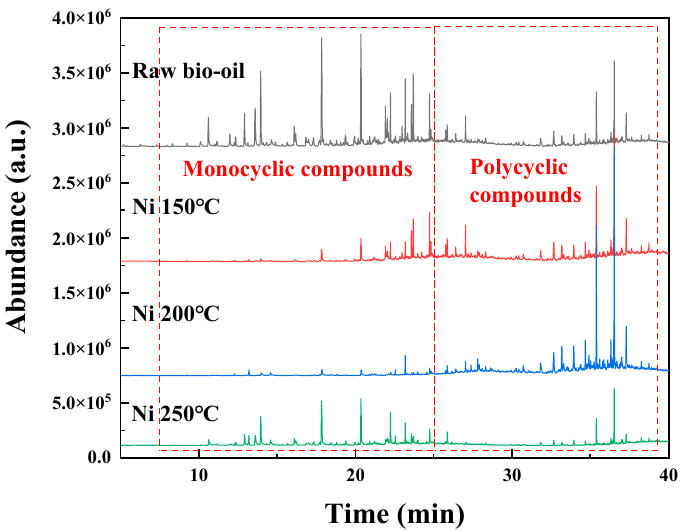
Figure 12. GC-MS results of bio-oil Pickering emulsion hydrodeoxygenation at 150 °C, 200 °C, and 250 °C.